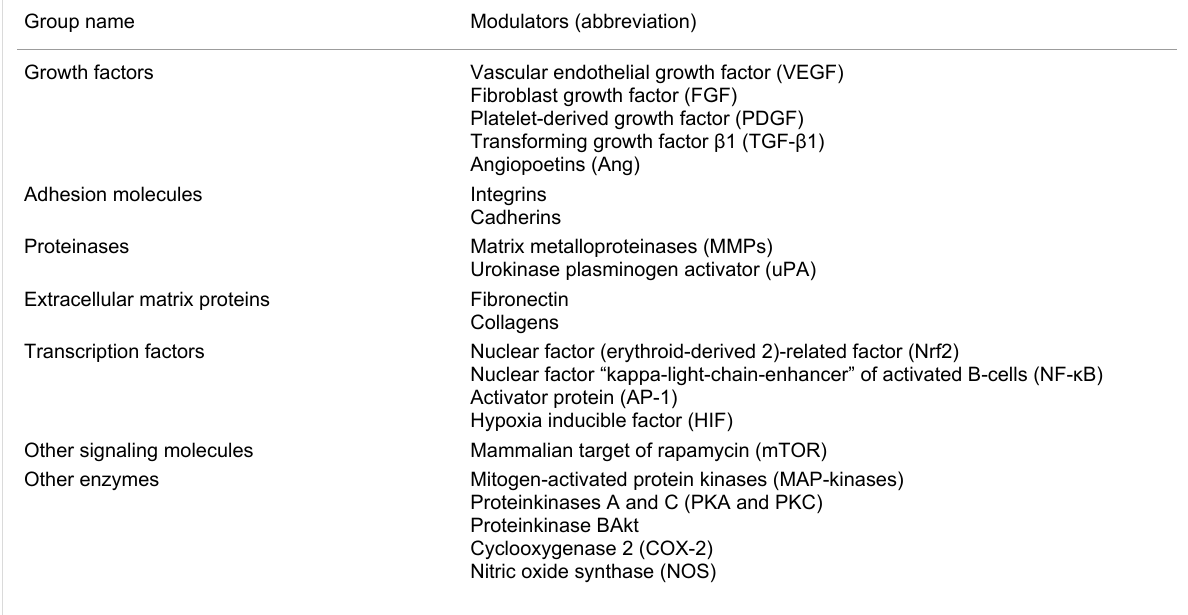
Table 1: Brief overview of the endogenous modulators involved in angiogenic